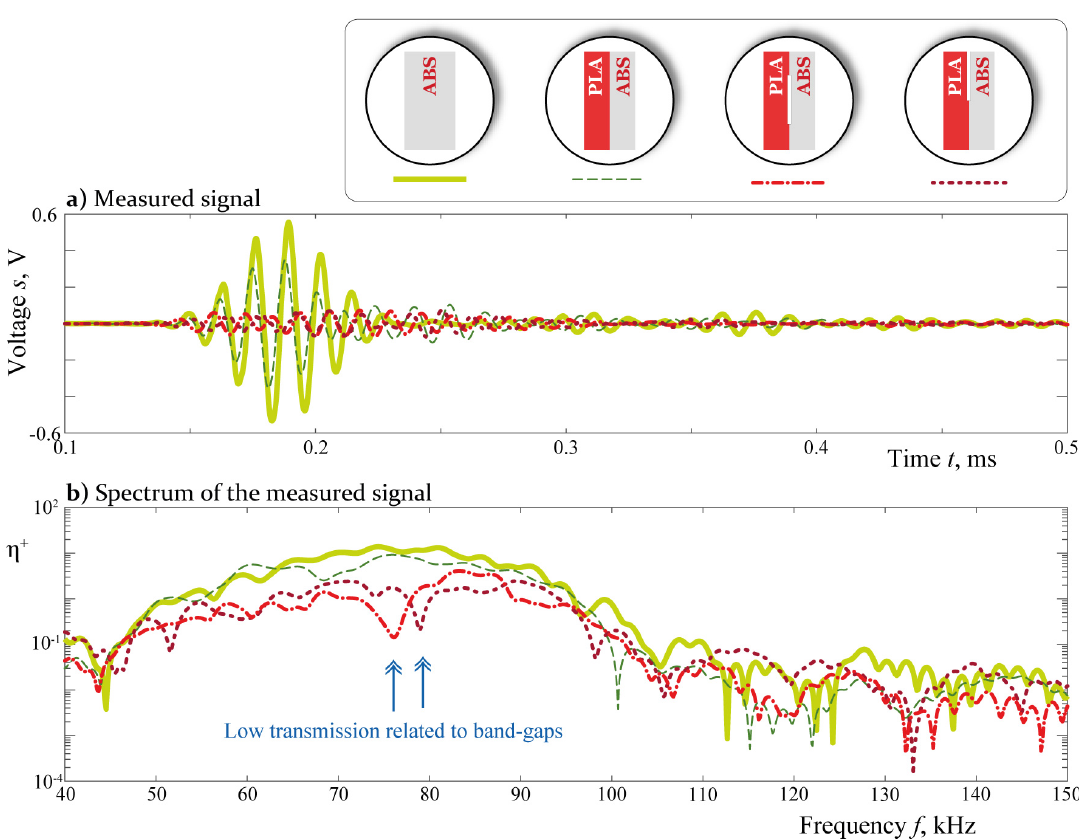
Figure 10. The measured signals s ( t ) and its transmission spectra η + ( f ) for four specimens in the case of Hann-windowed input with f 0 = 75 kHz: bulk ABS, layered AMM without voids, layered AMM with central voids, layered AMM with edge